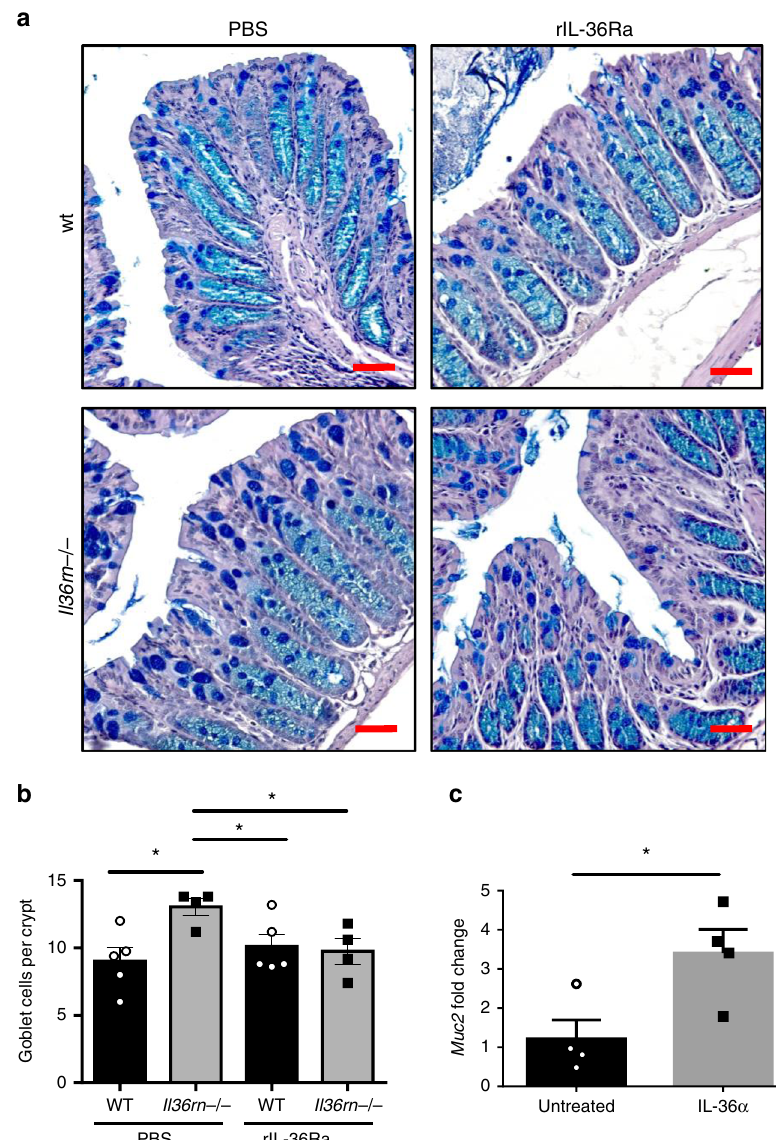
Fig. 6 IL-36 signalling increases goblet cell numbers and Muc2 gene expression. a , b Representative micrographs of AB/PAS-stained sections ( a ) and average goblet cells per crypt quantitation ( b ) in the colon of wt and Il36rn − / − mice after (day 6) three consecutive injections (days 1, 2, 3) of rIL-36Ra or PBS control ( n = 4 and 5 per group). Scale bar = 1 μ m. c Relative Muc2 gene expression in wt colon explants either untreated or stimulated for 4 h